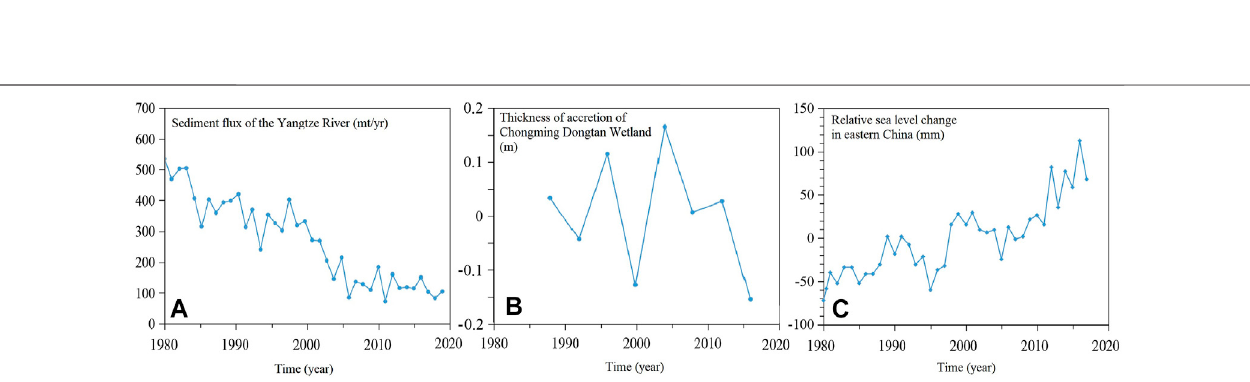
FIGURE8| Dongtanwetlandconservationplanning: (A) spatialdistributionoftheconservationprojects;and (B) functionalzoneplanningmapofDongtanNational Nature Reserve. Compiled by the Kunming Survey and Design Institute of State Forestry Administration (2010).